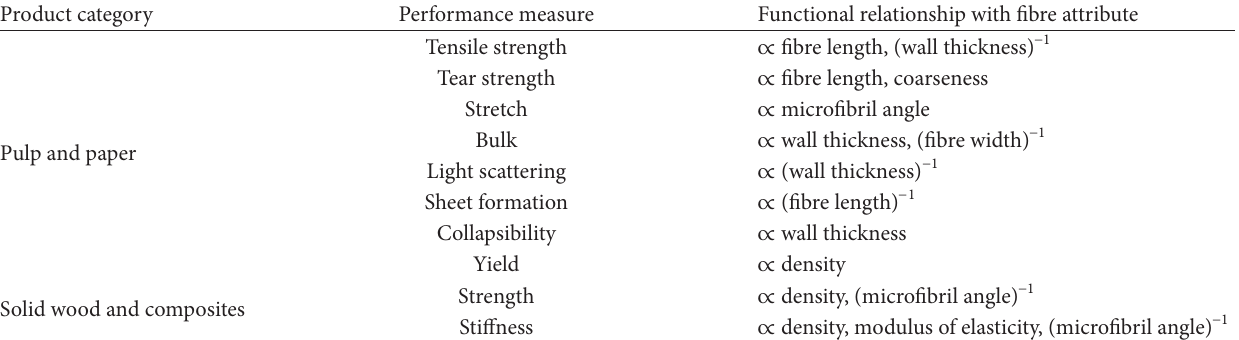
Table 1: Product-based performance measures and their relationship with fibre attributes (sensu